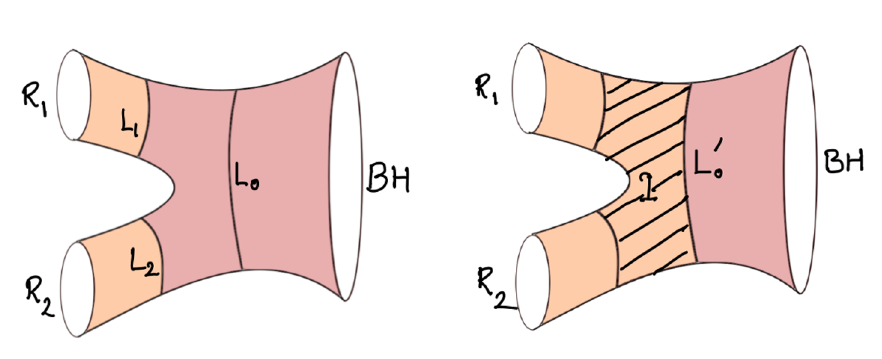
Figure 5. Change of preferred HRT in 3 boundary model. Left: before the Page time the HRT surface separates the R from the remainder of the pair of pants. Right: after the Page time L i shrunk to L 0 and the HRT surface has jumped to include the island I 0